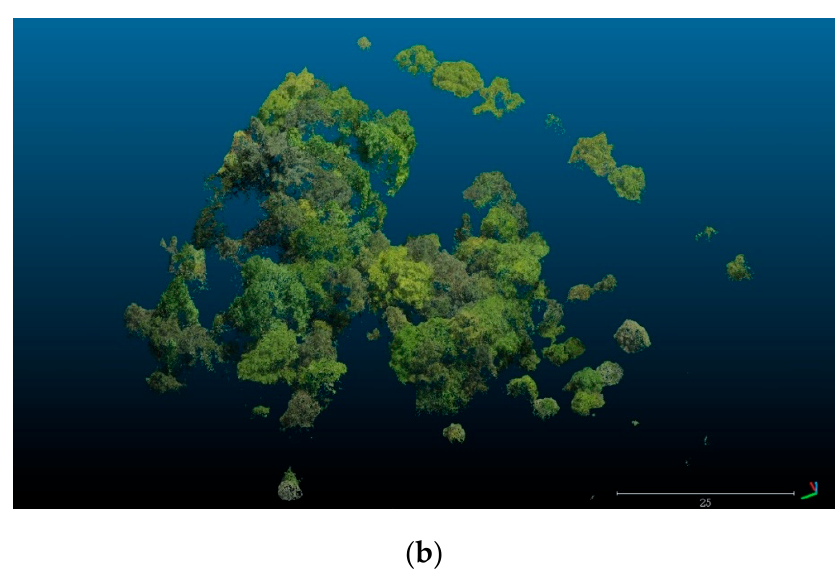
Figure 7. A comparison of the point cloud with or without the influence of sunlight. ( a ) Point cloud on 12 April 2019 and ( b ) point cloud on 14 April 2019, which was strongly affected by sunlight.